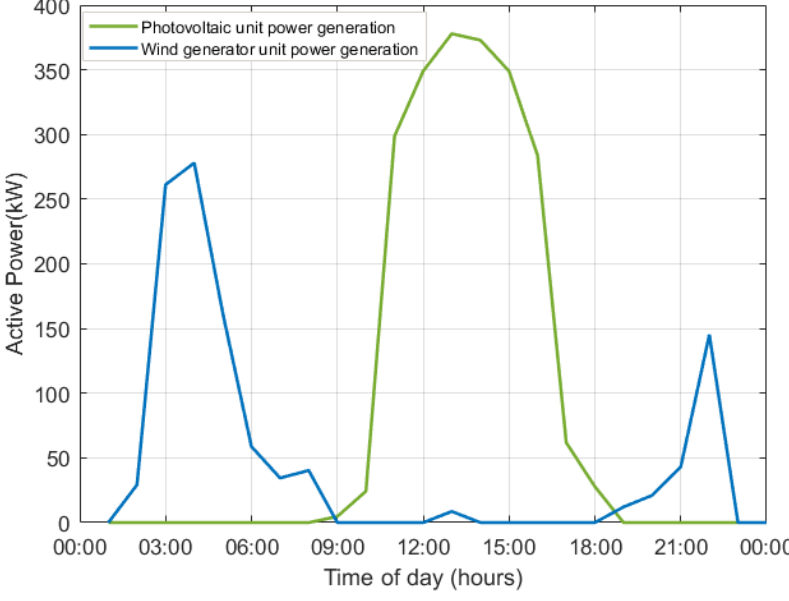
Figure 9. Photovoltaic and wind power generation.